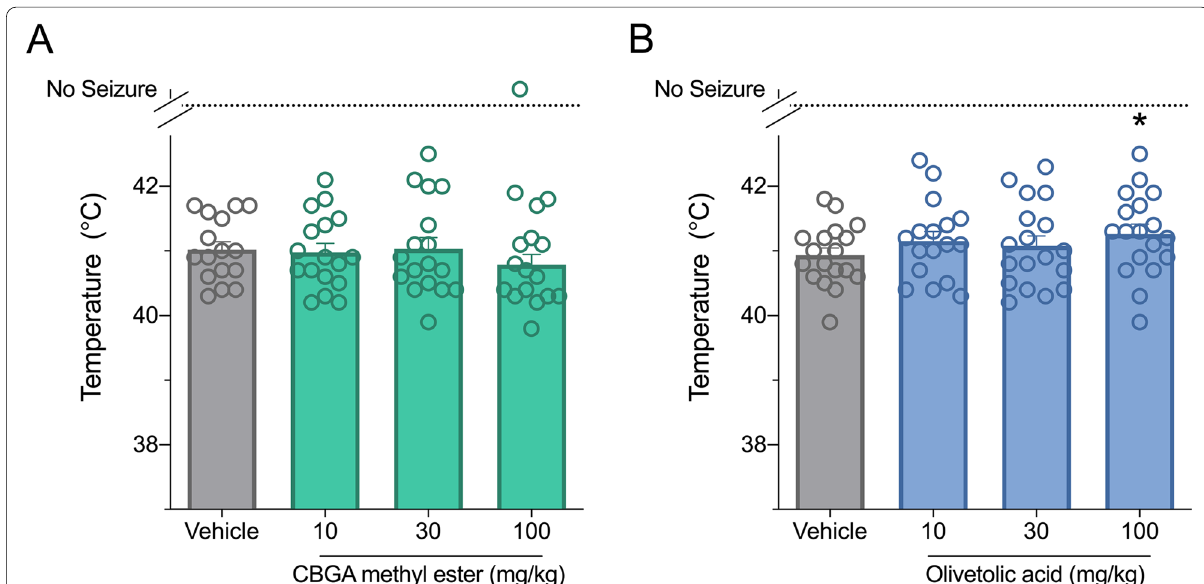
Fig. 2 Olivetolic acid is anticonvulsant against hyperthermia‑induced seizures in Scn1a + /‑ mice. Threshold temperature of individual mice for generalized tonic‑clonic seizure (GTCS) induced by hyperthermia in male and female Scn1a + /‑ mice following acute intraperitoneal treatment with varying doses of A CBGA methyl ester or B olivetolic acid. Olivetolic acid (100 mg/kg) significantly increased the temperature threshold for GTCS, indicating an anticonvulsant effect. CBGA methyl ester had no effect on thermally induced seizures. The average temperatures of seizure induction are depicted by the bars and error bars represent SEM, with n 17–19 per group (* p < 0.05, Mantel‑Cox logrank) =